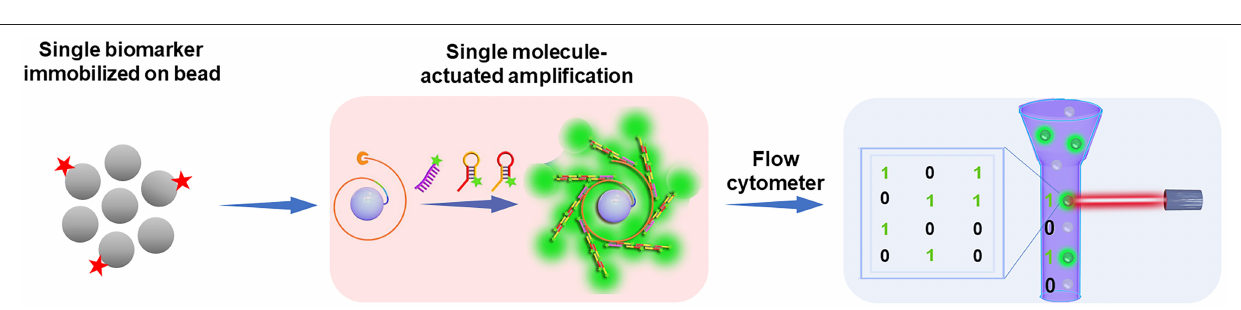
FIGURE 2 | Perspective on the digital counting platform: the integration of single molecule-initiated signal amplification strategies and conventional instruments (e.g., flow cytometer) may lead the future trend of digital assay technologies. Reproduced with permission from Fan et al. (2020). Copyright 2020, The Royal Society of